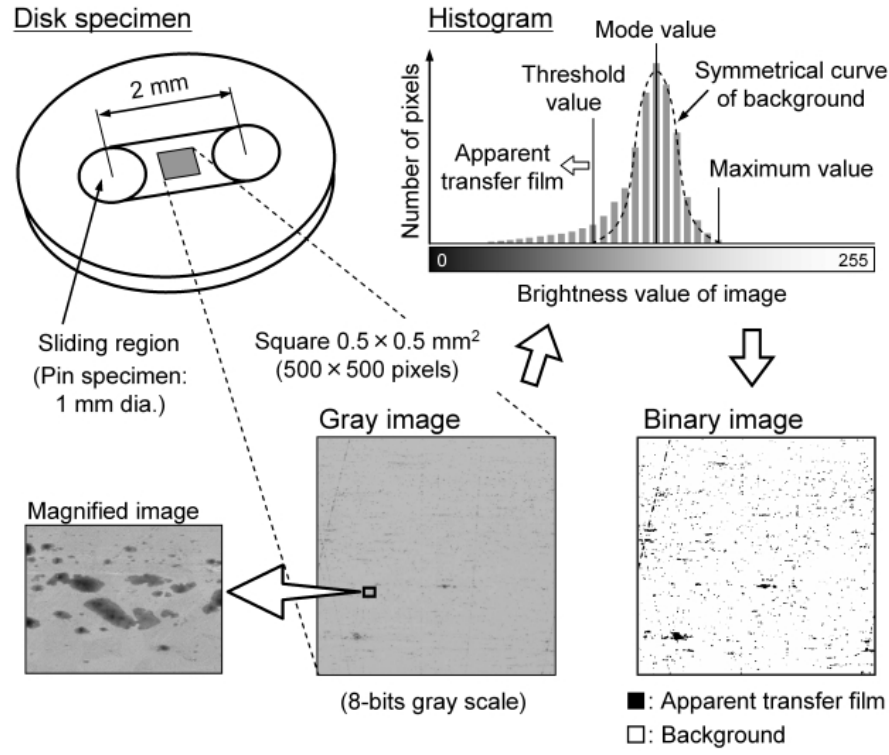
Fig. 3 Quantification procedure for the UHMWPE transfer film formed on the Co-28Cr-6Mo alloy